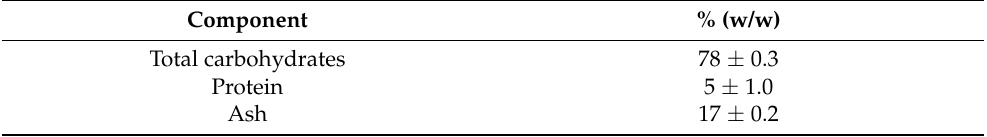
Table 1. Composition of the polysaccharides extracted from C. muelleri.